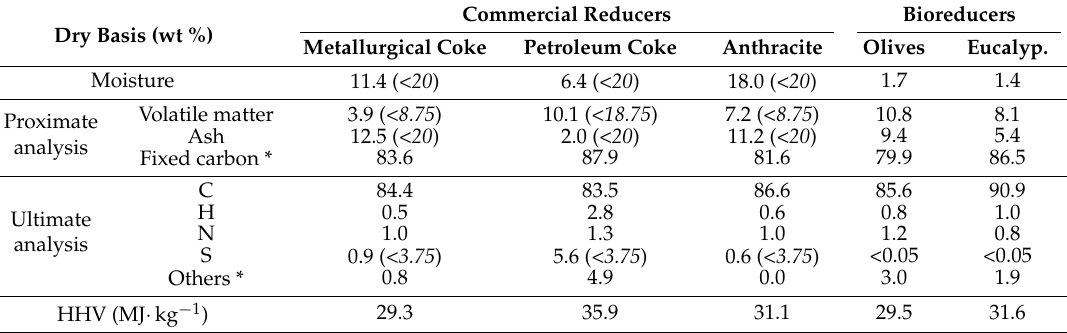
Table 5. Proximate and ultimate analyses of the commercial reducers and the bioreducers (750 ˝ C and 3 ˝ C ¨ min ´ 1